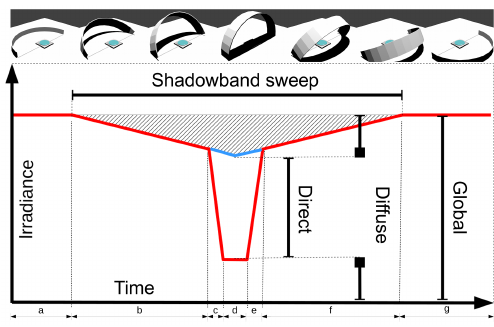
Figure A1. Schematic illustration of a shadowband sweep mea- sured by the GUVis shadowband radiometer. The red line indicates the measured irradiance. The figures on top illustrate the shadow- band position relative to the sensor during the sweep. The hatched area indicates the diffuse irradiance blocked from the sensor during the sweep. The blue line indicates the unknown blocked diffuse ir- radiance when the direct irradiance is at least partially blocked by the shadowband. It has to be estimated by the processing algorithm in order to accurately estimate the direct irradiance. The letters a– g indicate different periods during the sweep as follows: (a, g) the shadowband is in parking position, out of sight of the hemispheric field of view of the sensor; the measured irradiance corresponds to the global irradiance. (b, f) The shadowband is moving, but the di- rect irradiance of the Sun is not blocked from the sensor. (c, e) The direct irradiance is partially blocked by the shadowband as the band shades the sensor. (d) The direct irradiance is completely blocked by the shadowband.